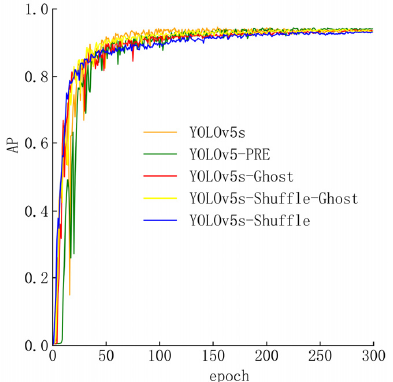
Figure 5. AP curve of YOLOv5-PRE and YOLOv5s models.